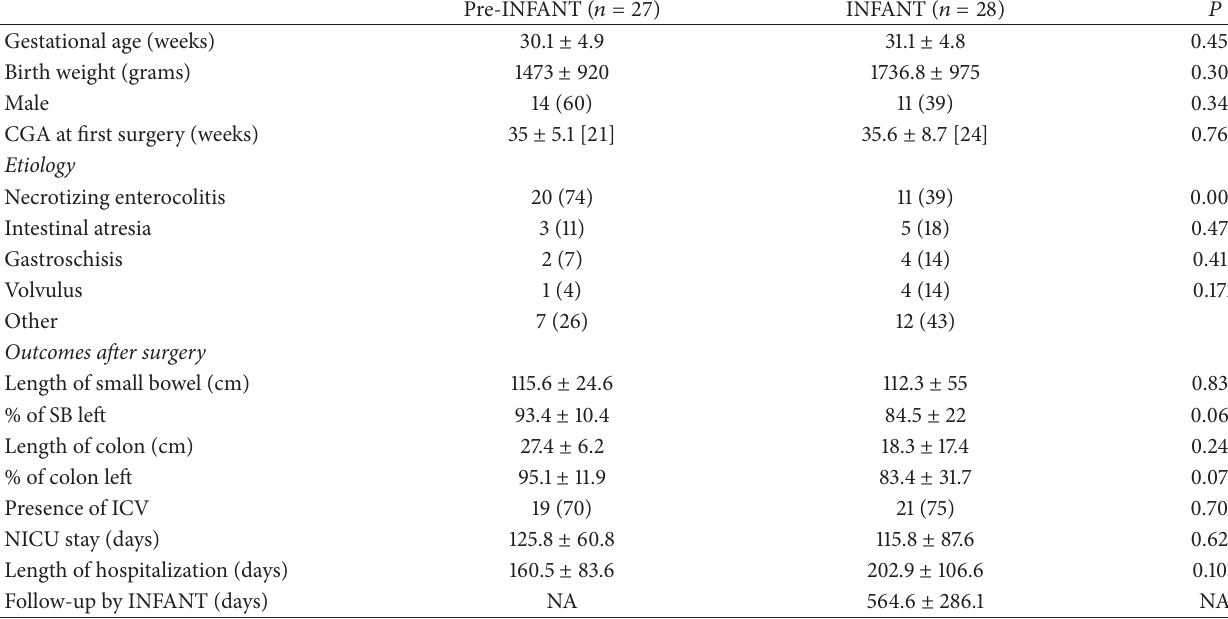
Table 1: Demographics and clinical characteristics of infants with SBS.